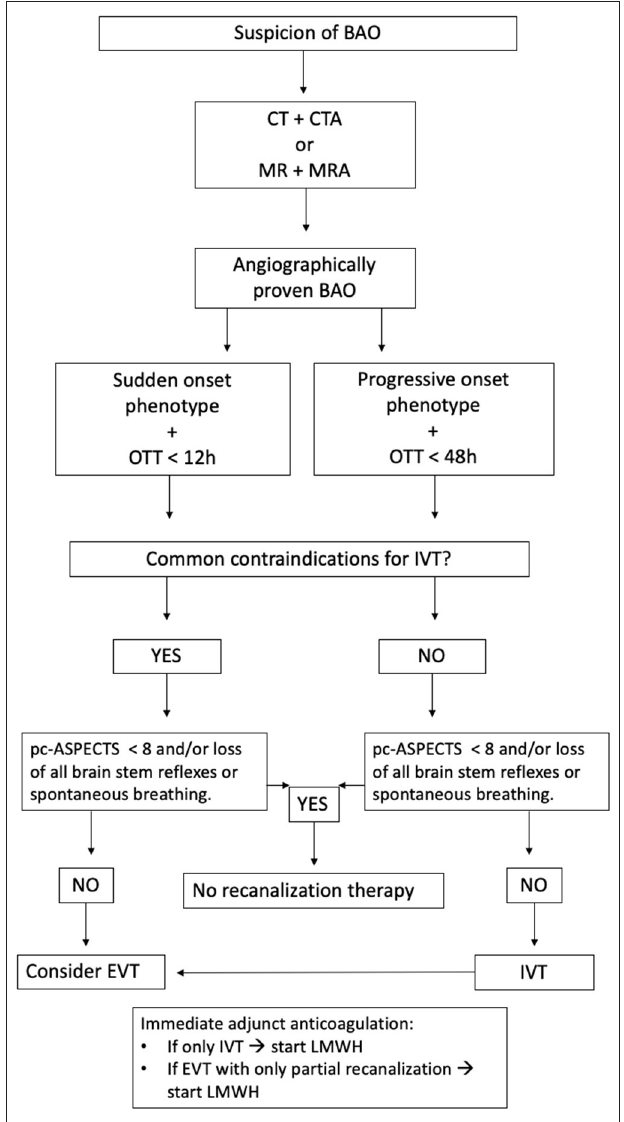
FIGURE 2 | Simplified flow chart on BAO treatment. BAO, Basilar artery occlusion; OTT, Onset-to-teatment time; IVT, Intravenous thrombolysis; pc-ASPECTS, posterior circulation Acute Stroke Prognosis Early CT Score; EVT, Endovascular treatment; LMWH, Low-molecular-weight